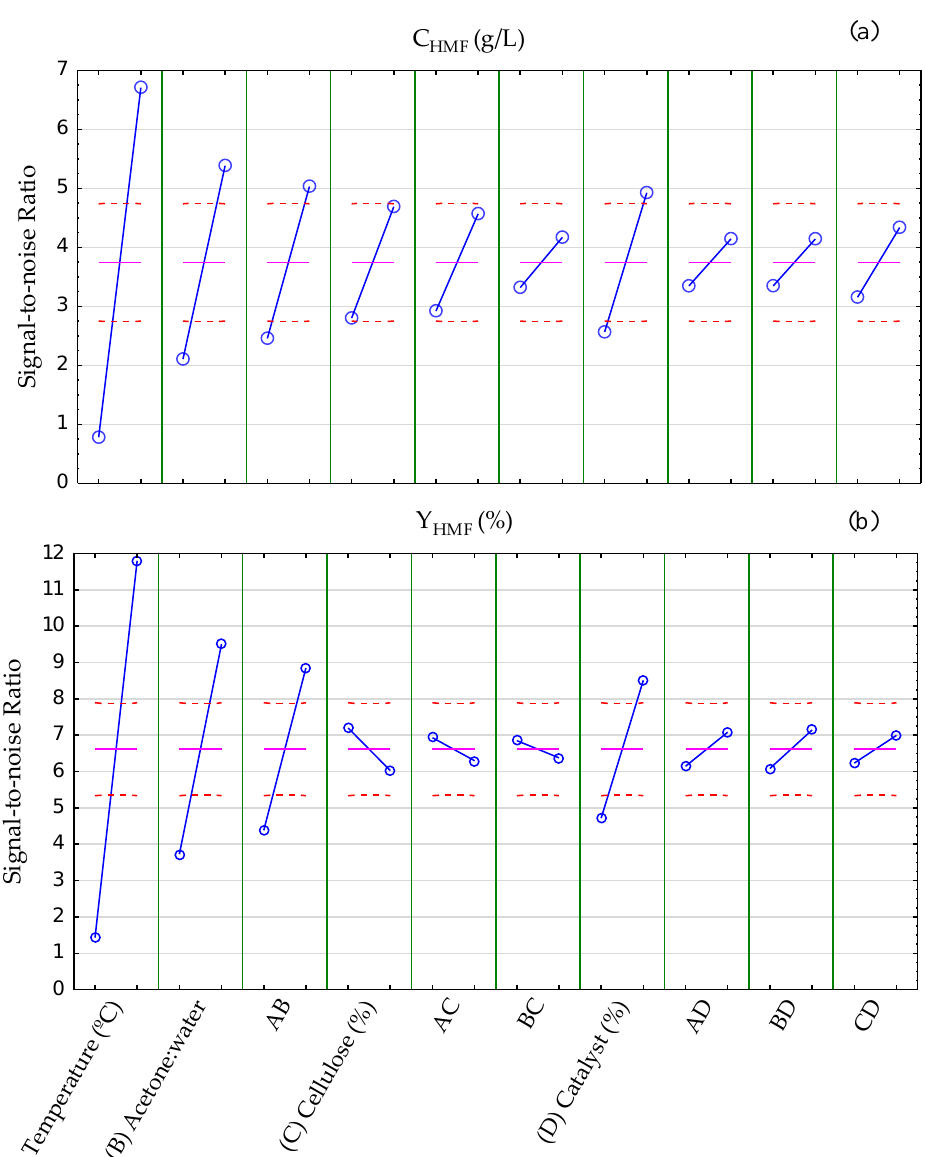
Figure 4. Signal-to-noise ratio (SN ratio) of ( a ) HMF concentration (C HMF g / L) and ( b ) HMF yield (Y HMF %) as response variables.